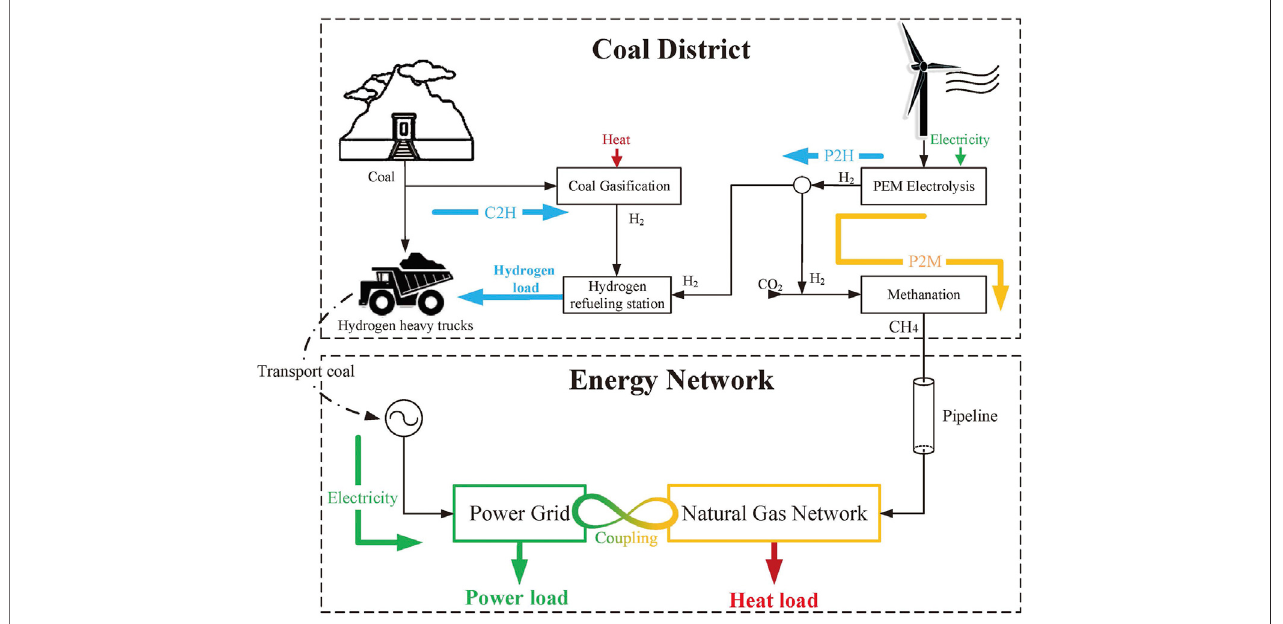
FIGURE 1 | Scenario of coal district considering hydrogen heavy trucks and P2G equipment model of wind power to H 2 and CH 4 .